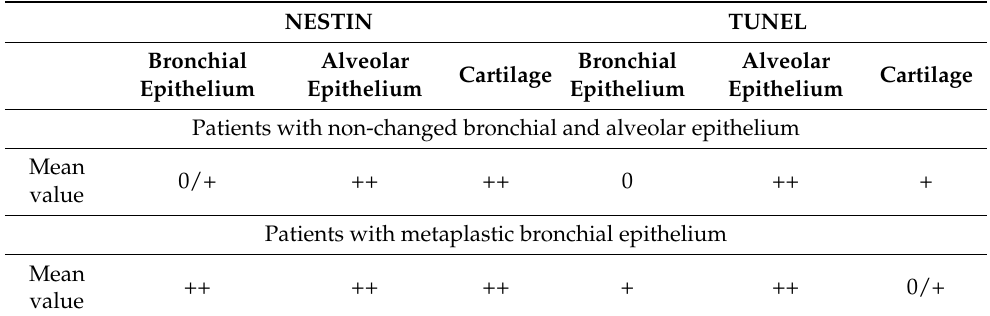
Table 1. Appearance and relative number of nestin-containing and apoptotic cells in 19 relatively healthy lung tissue specimens.